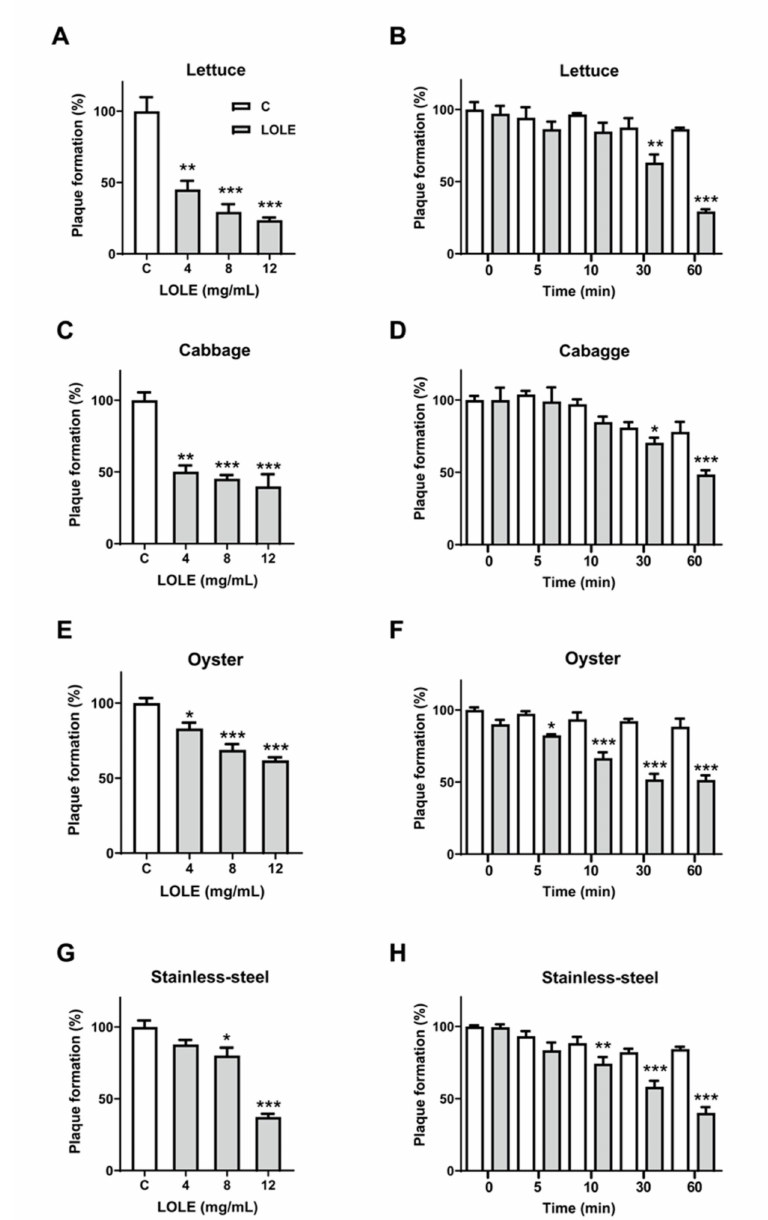
Figure 4. Lindera obtusiloba leaf extract (LOLE) anti-noroviral e ff ects on model food systems. Lettuce, cabbage, oyster and stainless-steel surfaces were spot-inoculated with murine norovirus (MNV-1) (10 5 PFU / mL) and plaque reduction assays were performed to determine the anti-noroviral e ff ects of LOLE. ( A , C , E , G ) Dose-response experiments: MNV-1 virus particles were pretreated with LOLE solutions (1, 2, 4, 8, and 12 mg / mL) for 1 h at 25 ◦ C before infecting RAW 264.7 cells. ( B , D , F , H ) Time-response experiments: virus particles were pretreated with LOLE (12 mg / mL) for 0, 5, 10, 30 and 60 min at 25 ◦ C. MNV-1 infectivity was calculated as a percentage of plaque formation using dimethyl sulfoxide (DMSO)-treated samples as a control. The white bars represent the control groups, whereas the gray bars represent the intervention groups. Results are expressed as the percentage of neutralized virus compared to control (mean ± SEM; n = 3). * p < 0.05, ** p < 0.01, *** p < 0.001 vs.